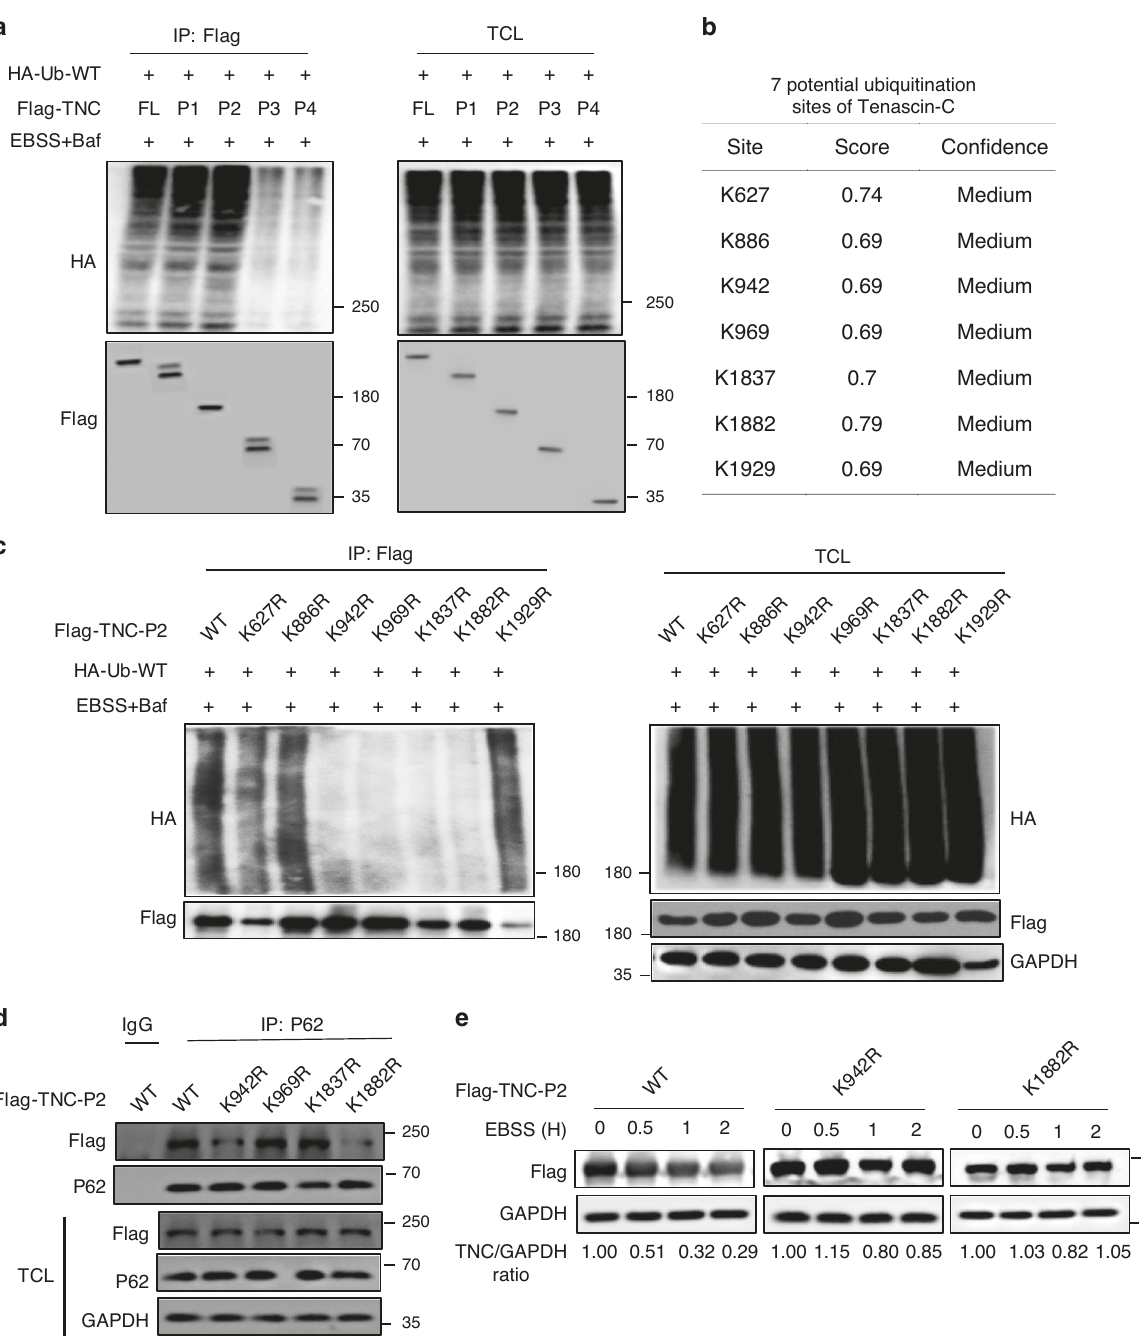
a key immunosuppressive factor in TNBC tumours. Our fi nd- ings also identify the crosstalk between autophagy and immune compartments as targetable component for potential ther- apeutic strategies for TNBC patients with poor ICB therapy response.